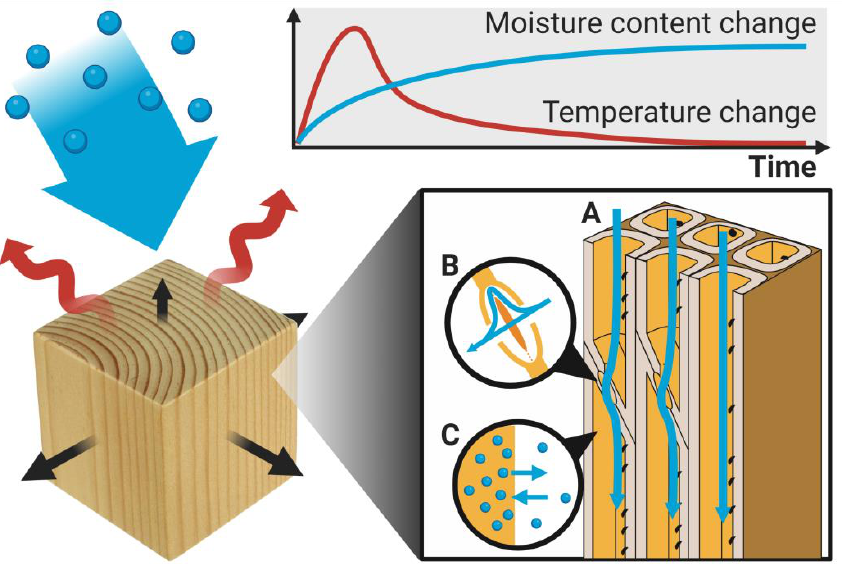
Figure 3. Sorption kinetics in wood involves a change in moisture content and temperature over time. Here it is illustrated by water vapor absorption, which results in an increase in mass (moisture content, blue curve), dimensions (swelling, black arrows), and temperature (red arrows and curve) in the approach to equilibrium. During the absorption process, water vapor diffuses through the porous wood microstructure (blue arrows), where it goes through lumina ( A ), pits ( B ), and cell walls, while constantly exchanging water molecules ( C ) between the water vapor and the moisture within the cell walls.